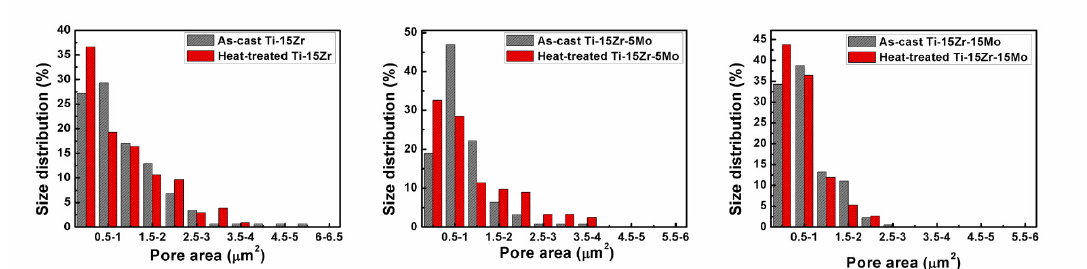
Figure 5: Normal distribution of the pore areas.